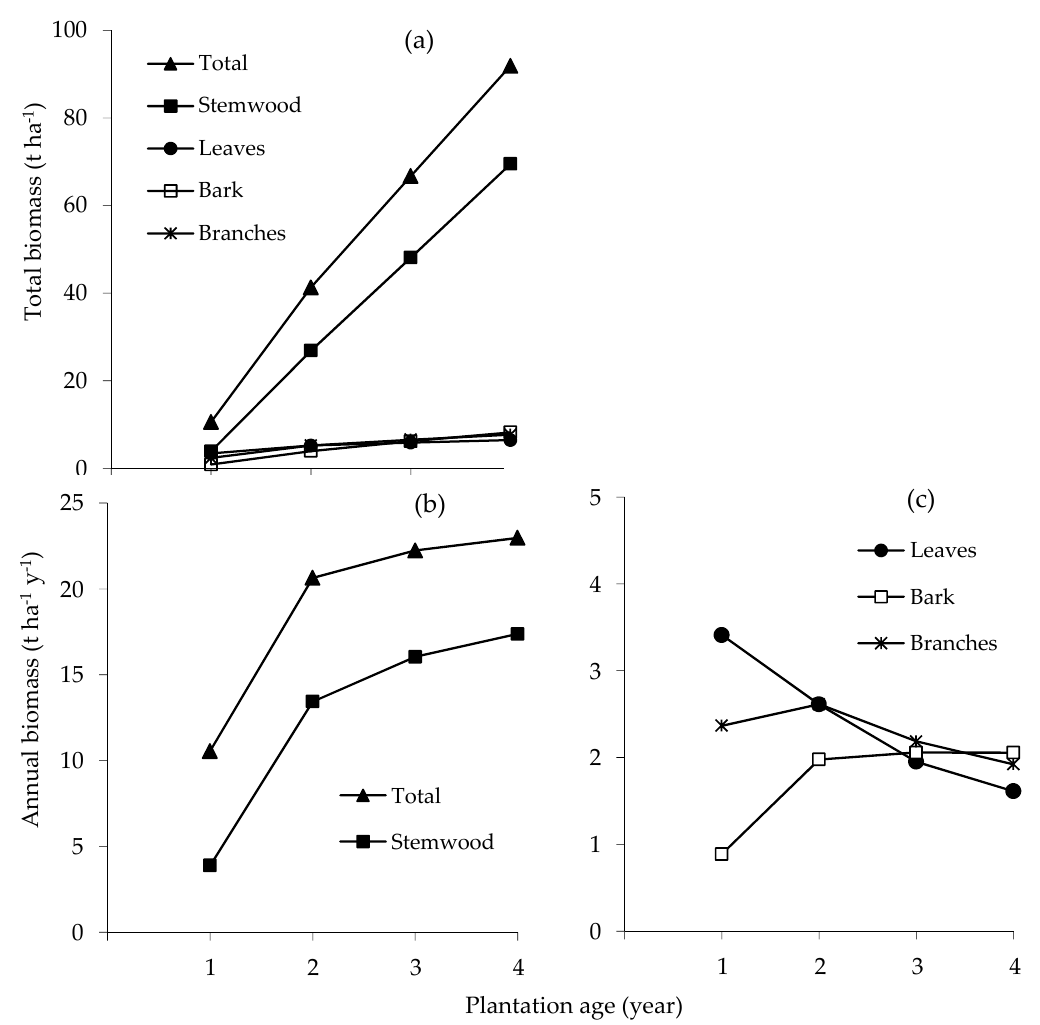
Figure 2. Accumulation of total biomass ( a ); mean annual rate of accumulation of total and stemwood ( b ); and leaf, bark and branch biomasses ( c ) of E. pellita with stand age.